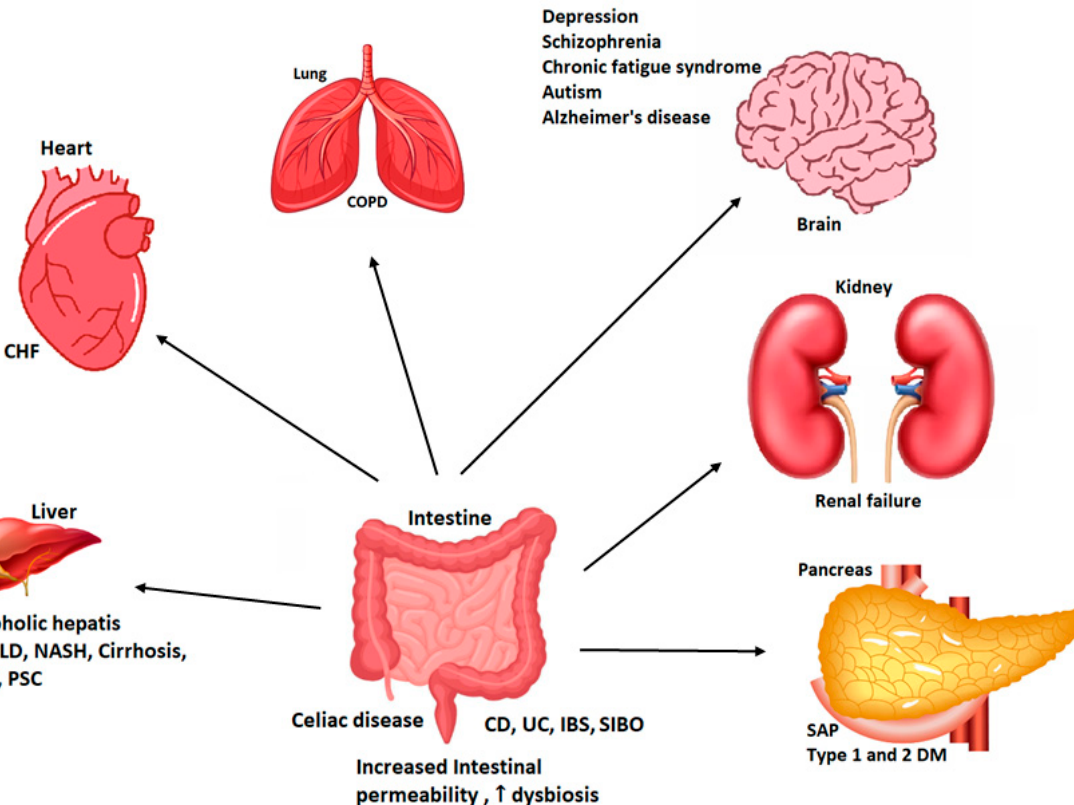
Figure 2. Relationship between leaky gut syndrome and intestinal dysbiosis with various diseases. NAFLD: nonalcoholic fatty liver disease; NASH: nonalcoholic steatohepatitis; PBC: primary biliary cholangitis; SAP: severe acute pancreatitis; DM: diabetes mellitus; SIBO: small intestinal bacterial overgrowth; COPD: chronic obstructive pulmonary disease; CHF: congestive heart failure; CD: Crohn’s disease; UC: ulcerative colitis (ulcerative colitis); IBS: inflammatory bowel diseases.